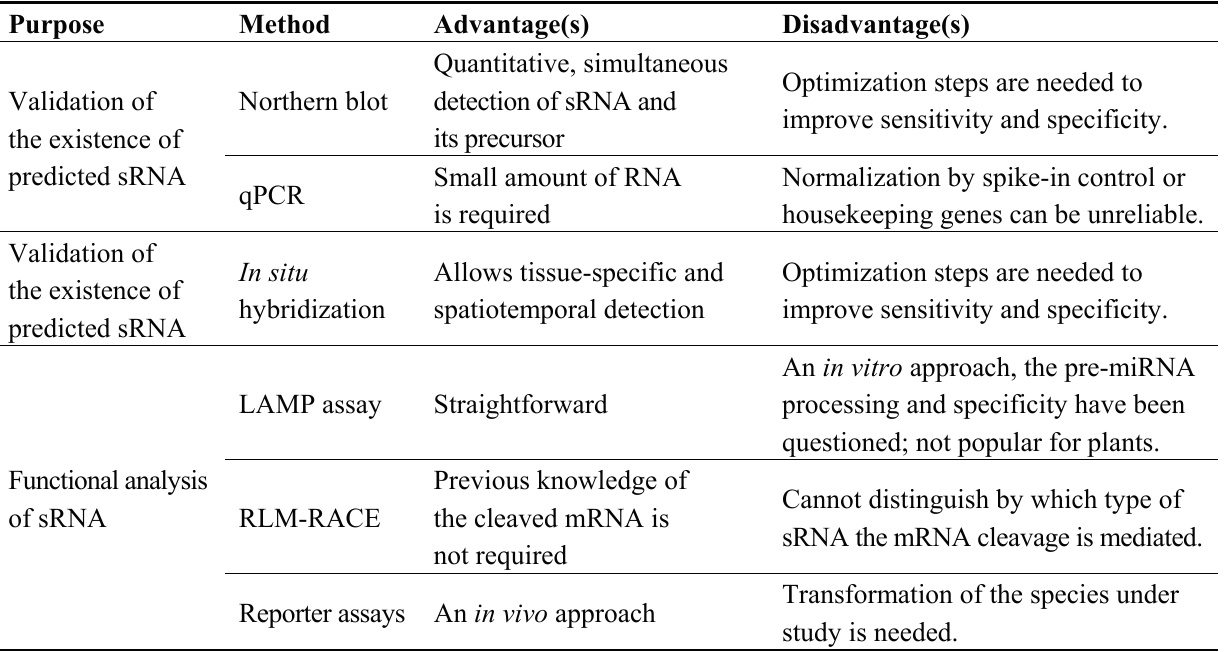
Table 5. Comparison of methods for sRNA